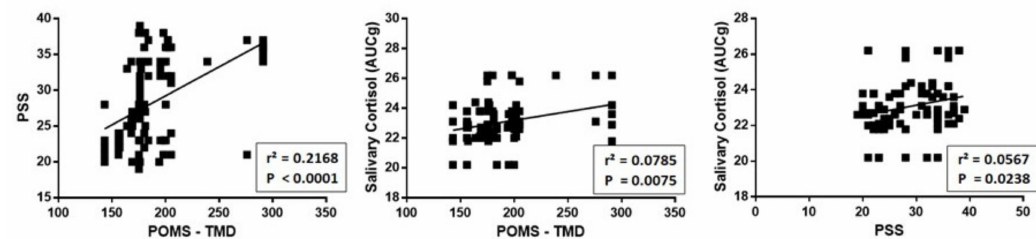
Figure 3. Relationship between POMS, expressed as TMD, PSS and level of salivary cortisol for each participant. As can be seen, there is a significant positive relationship between these three measures.